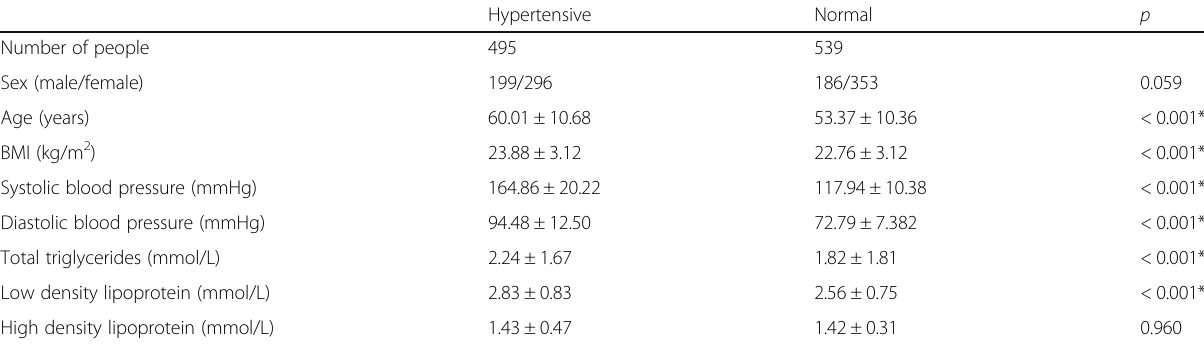
Table 1 Survey indicators and statistical analysis of the study participants Hypertensive